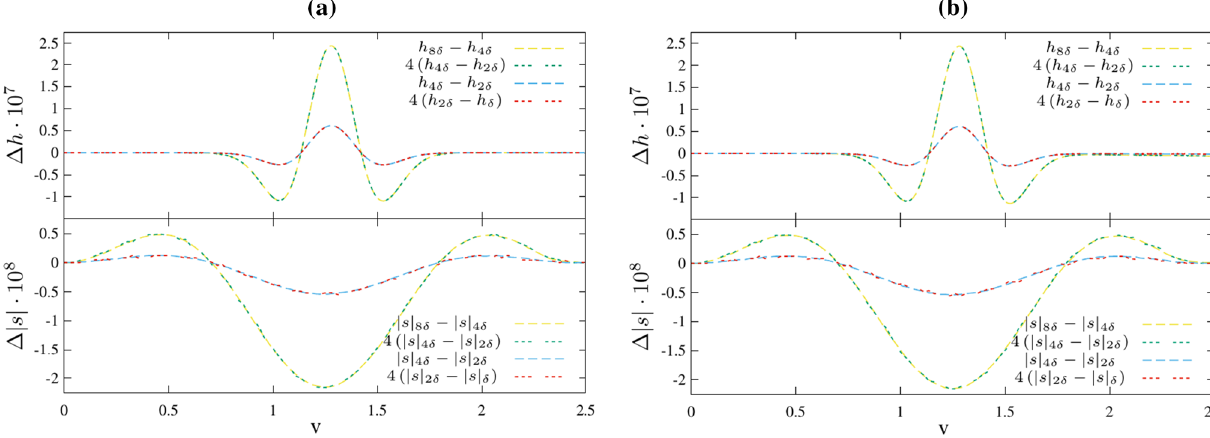
Fig. 18 The convergence of the code. The differences between the scalar field functions, (cid:21) h , and the moduli of complex scalar field, (cid:21) | s | , calculated on grids with different integration steps (multiples of